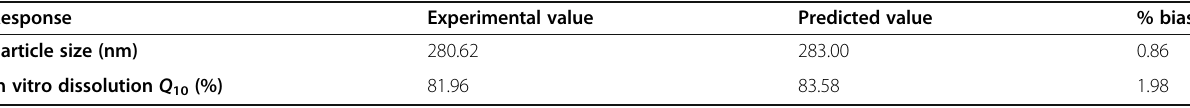
Table 5 Percentage bias for checkpoint batch